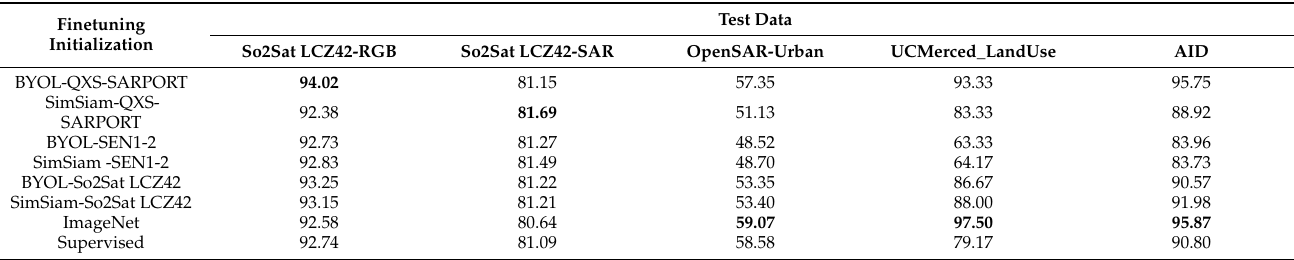
Table 3. Overall accuracy (%) obtained by BYOL and SimSiam pretrained on different dataset on the downstream test sets, which are finetuned